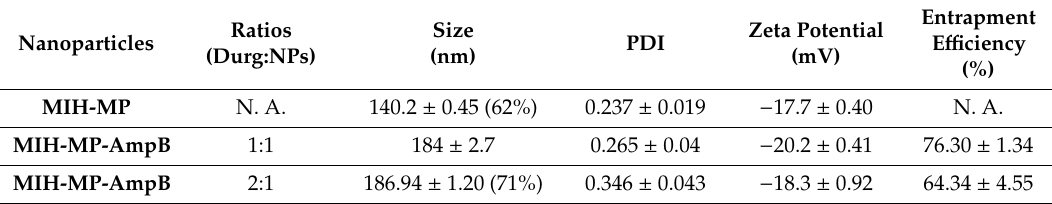
Figure 3. ( A ) Morphology of vacant MIH-MP nanoparticles. ( B ) Morphology of MIH-MP-AmpB nanoparticles. ( C ) Fourier transformed infrared spectra of Amp B along with MIH-MP-AmpB. Table 1. Average size distribution, zeta potential, PDI, drug entrapment efficiency at several ratios of MIH-MP nanoparticles. The percentages for each population from DLS is shown. Since the 1:1 formulation provided optimal drug loading, only this was used for further studies.